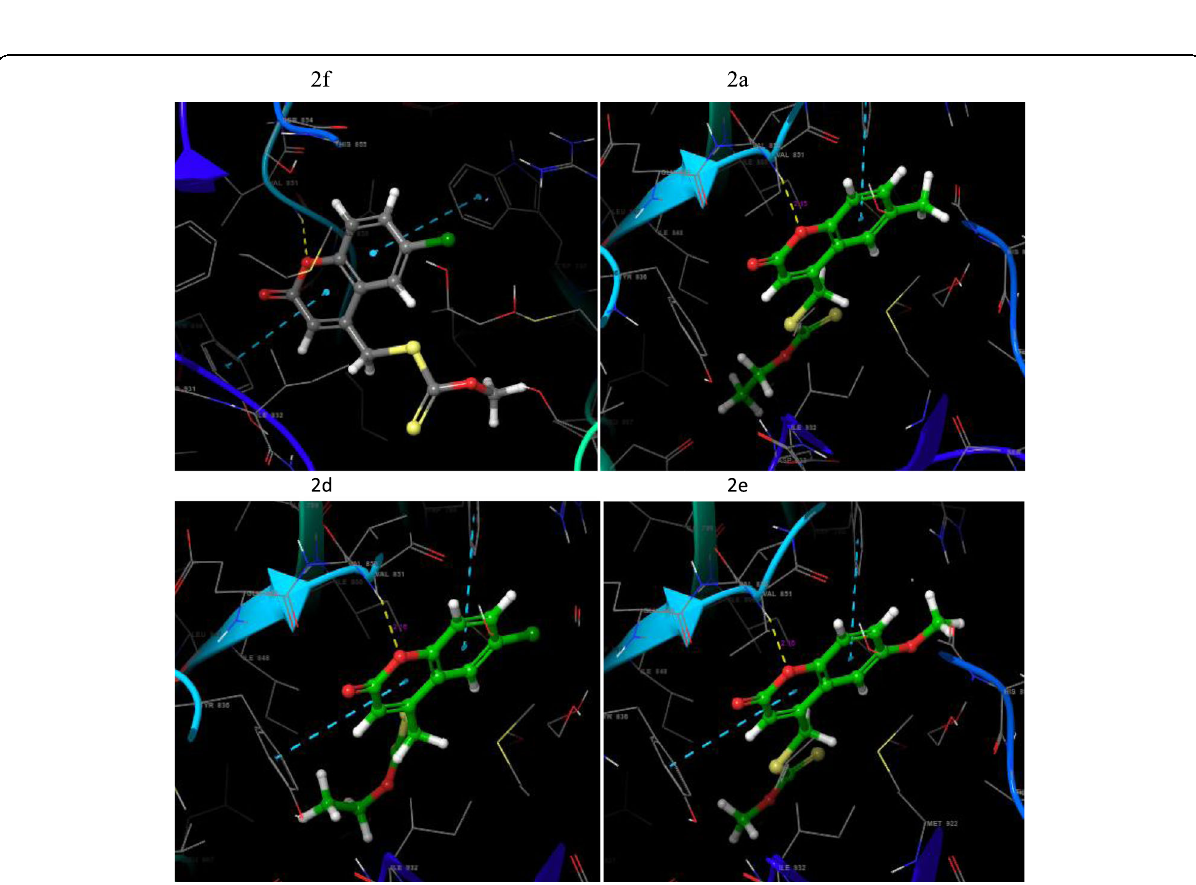
Fig. 5 Interaction of 2f, 2a, 2d, and 2e respectively with PIK3C α 3D diagrams is given below with yellow dotted line represents hydrogen bond sky blue dotted lines represents pi-pi stacking